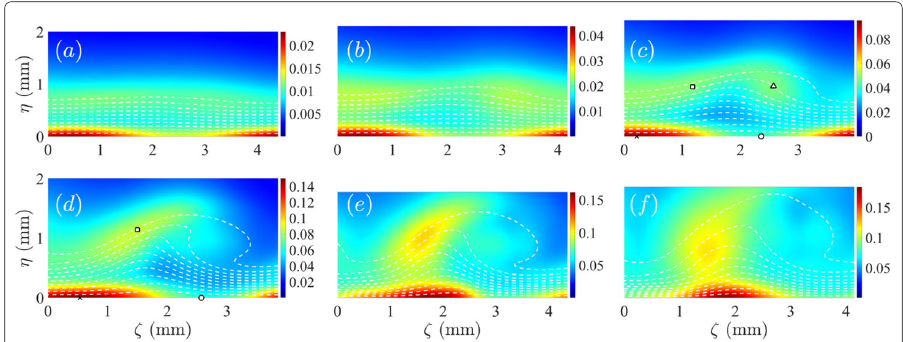
Fig. 10 The evolution of p rms in the wall-normal plane along the vortex path V2. The dashed lines represent the temporal mean axial velocity. The markers in c , d are probe points. Axial locations are from x = 220 mm to 320 mm by an increment of 20